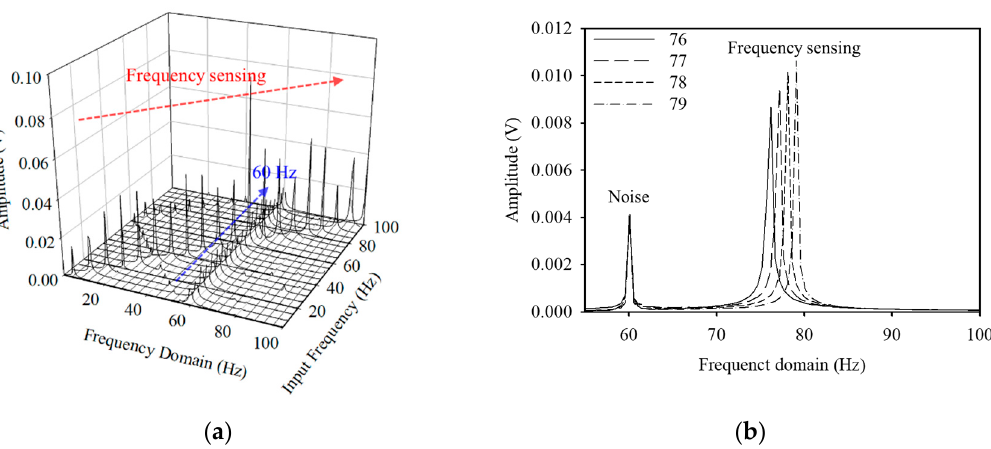
Figure 5. ( a ) Fast Fourier transform (FFT) matching according to the input frequencies and ( b ) narrow ranges of frequencies.